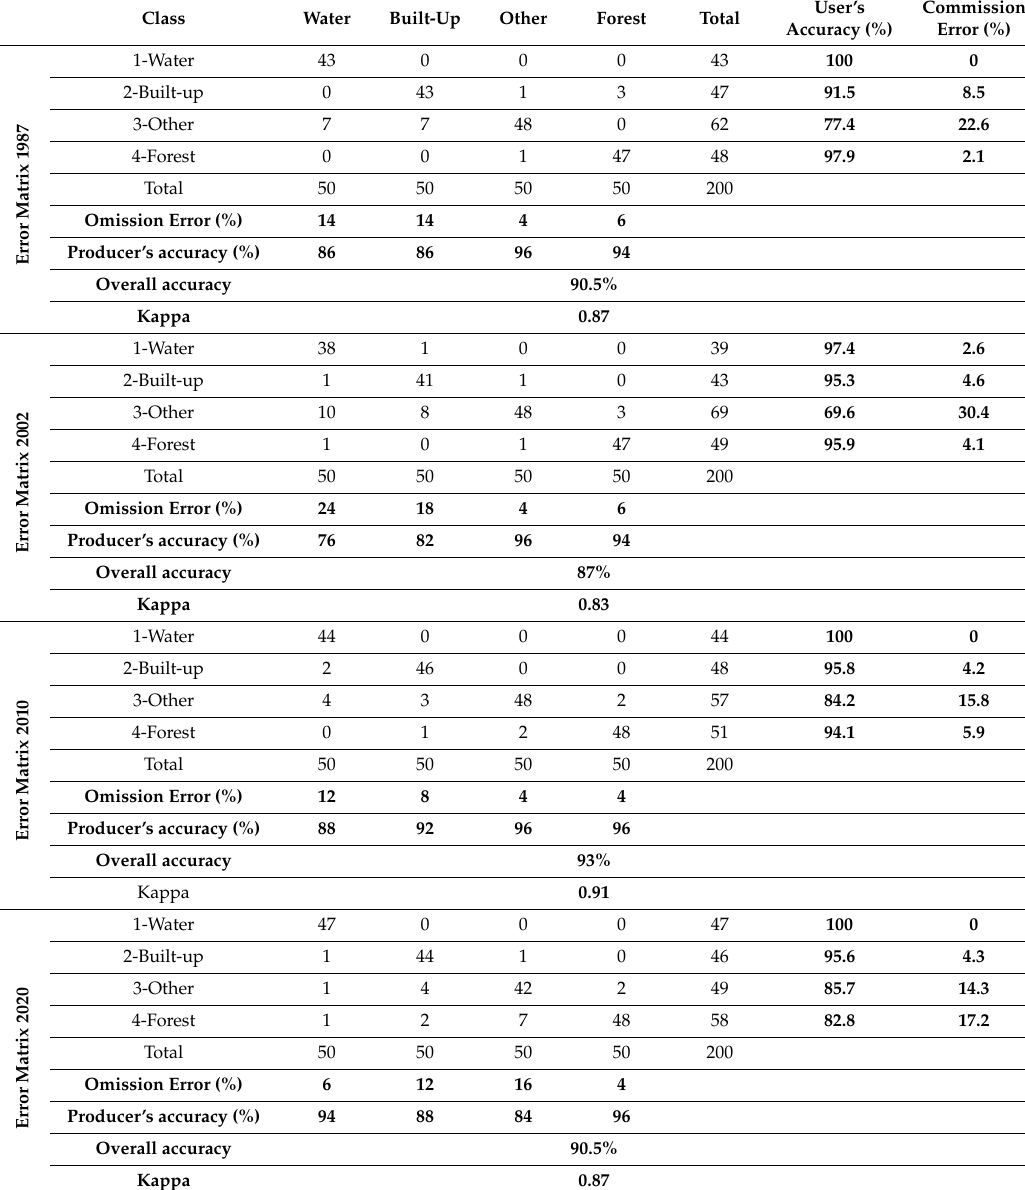
Table 2. Error matrices of the LULC with commission and omission errors, overall accuracy, producer’s accuracy, user’s accuracy, and kappa coe ffi cient (bold values) for the years 1987, 2002, 2010, and 2020.